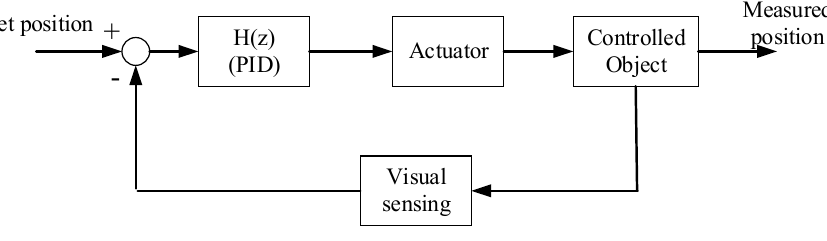
Figure 4. Schematic diagram of the control system.